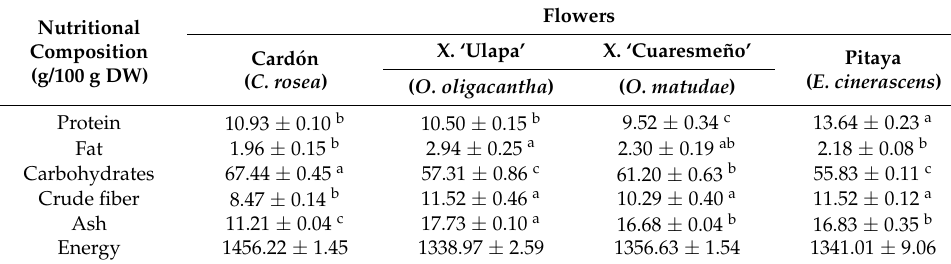
Table 1. Nutritional composition of cactus flowers from Hidalgo, Mexico. Nutritional Composition Card ó n ( C. rosea